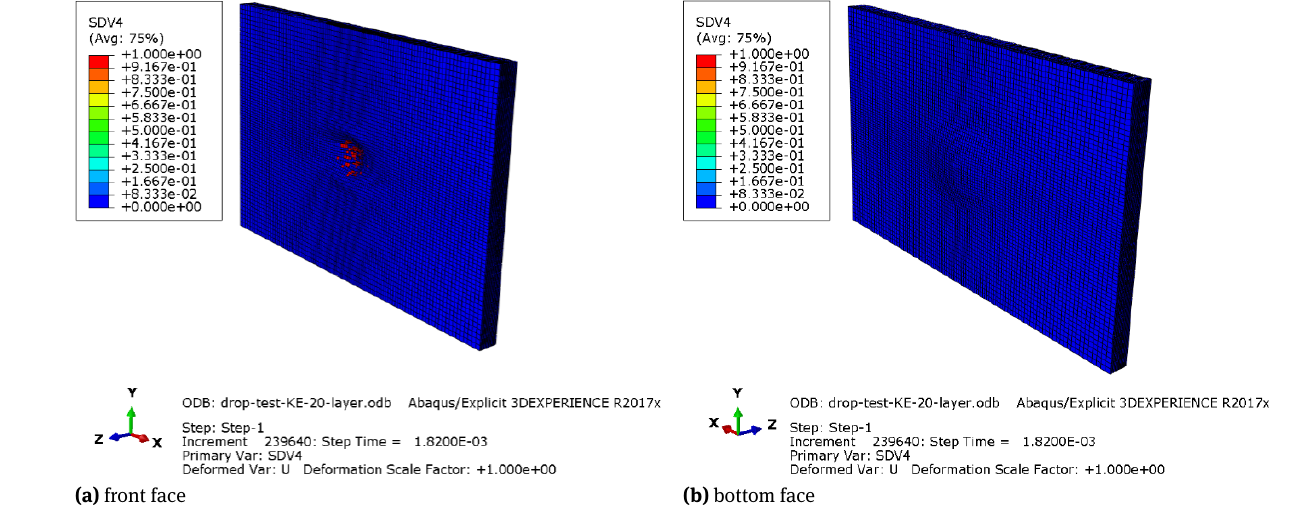
Figure 9: Matrix compression intralaminar damage of Kevlar